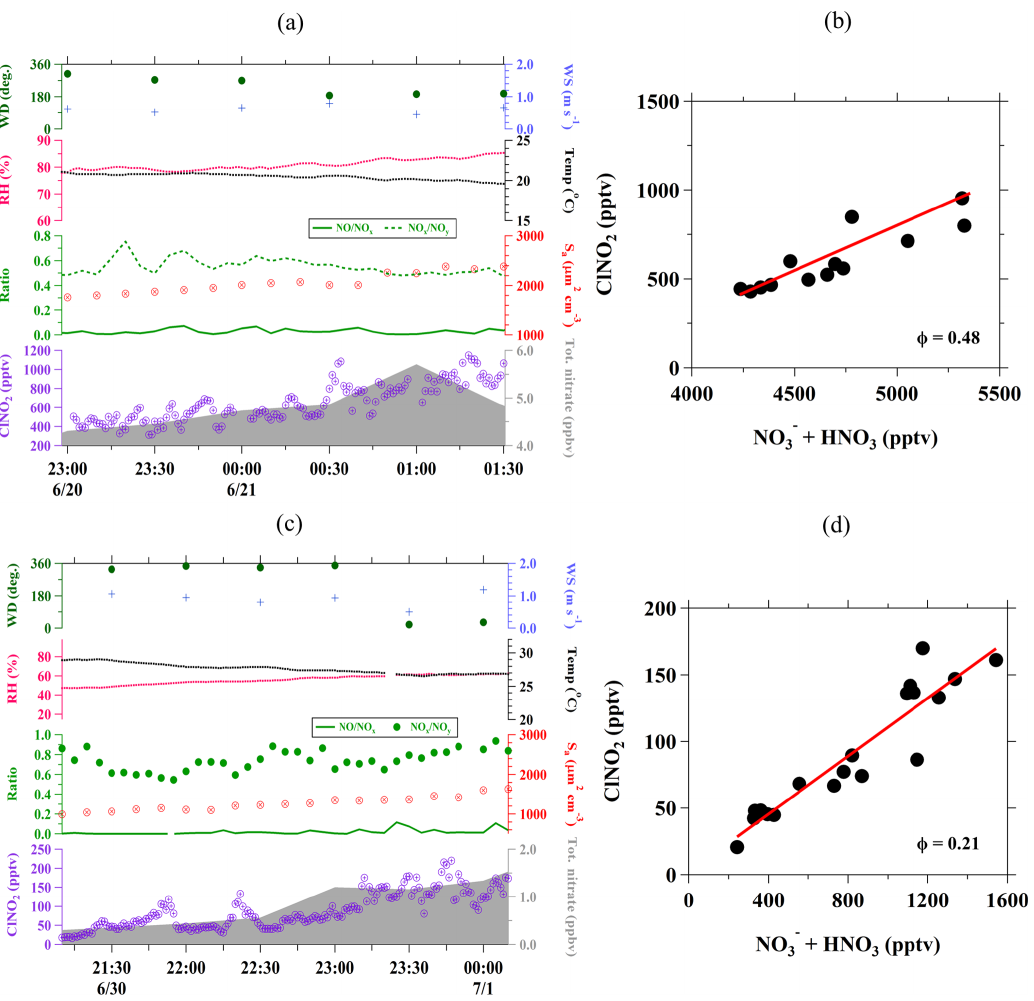
+ HNO 3 ) concentrations during the relatively constant 3 + HNO 3 to estimate the ClNO 2 yield ( φ ) for these two cases are shown in 3